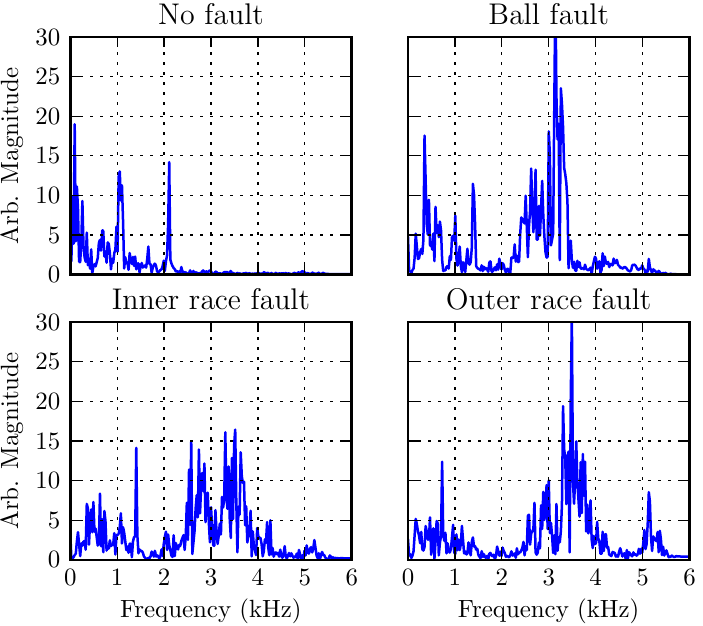
Figure 6. Vibration spectra of an electric motor with various drive-end bearing faults at 1 , 772 RPM and 2 HP